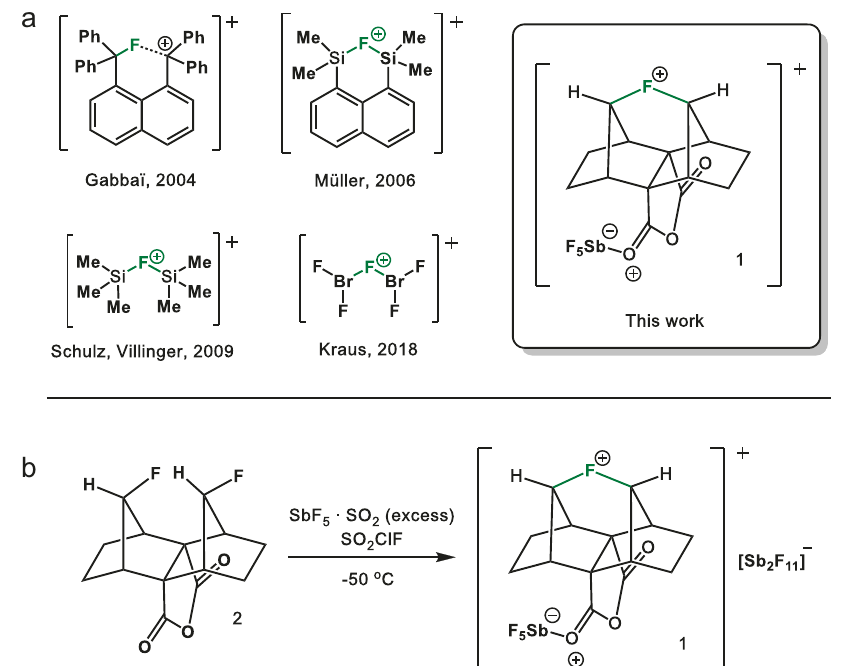
Fig. 1 Overview of fl uoronium ions in the condensed phase. a Crystallographically characterized fl uoronium ions 16,17,19 – 23 . Note that the formal charges shown inside a circle do not represent the actual charge of the corresponding atoms. b Synthesis of the fl uoronium salt [ 1 ][Sb 2 F 11